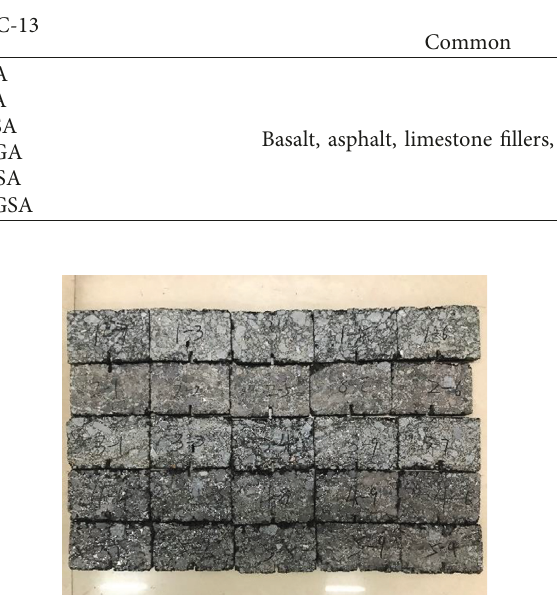
Figure 3: Asphalt concrete beams.